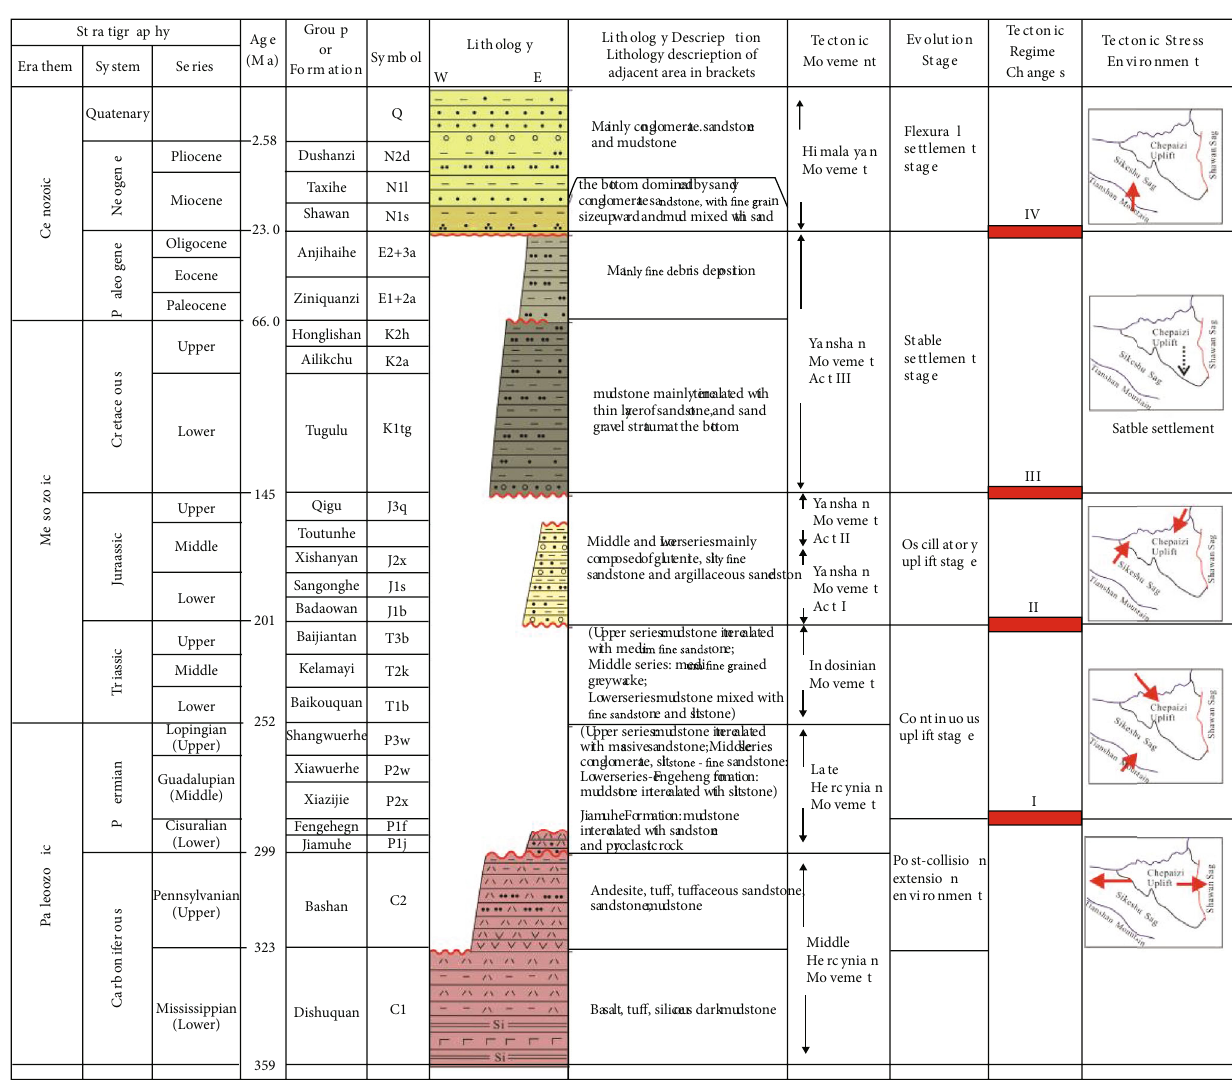
Figure 6: The characteristic of tectonic regime changes in the Chepaizi